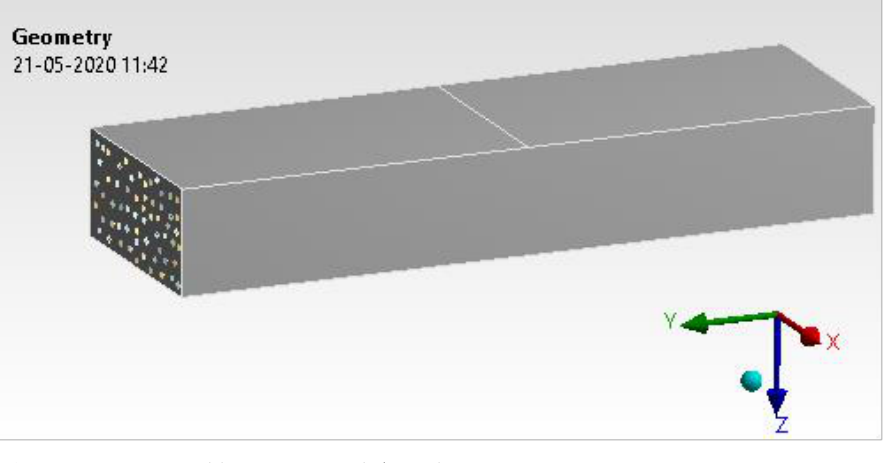
Figure 11. Epoxy and h-Boron Nitride/Graphene.